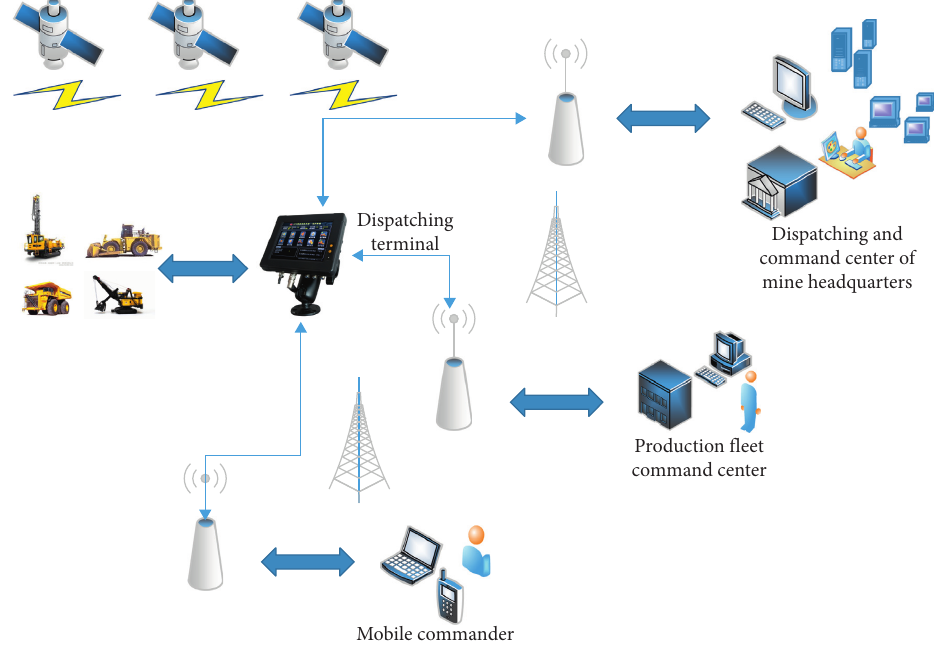
Figure 2: Schematic diagram of the dispatching